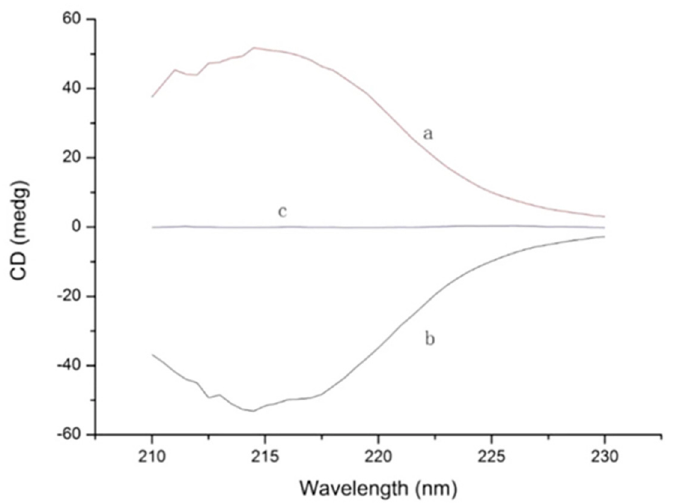
Figure 3. The circular dichroism spectra of L- and D-phenylalanine. (a and b) are the circular dichroism spectra of the same amount of L- and D-phenylalanine, respectively. They have an approximately equal but opposite signal, while (c) is the spectrum from a mixture (racemate) of the same amount of L- and D-phenylalanine. Reprinted with per-mission from reference [95]